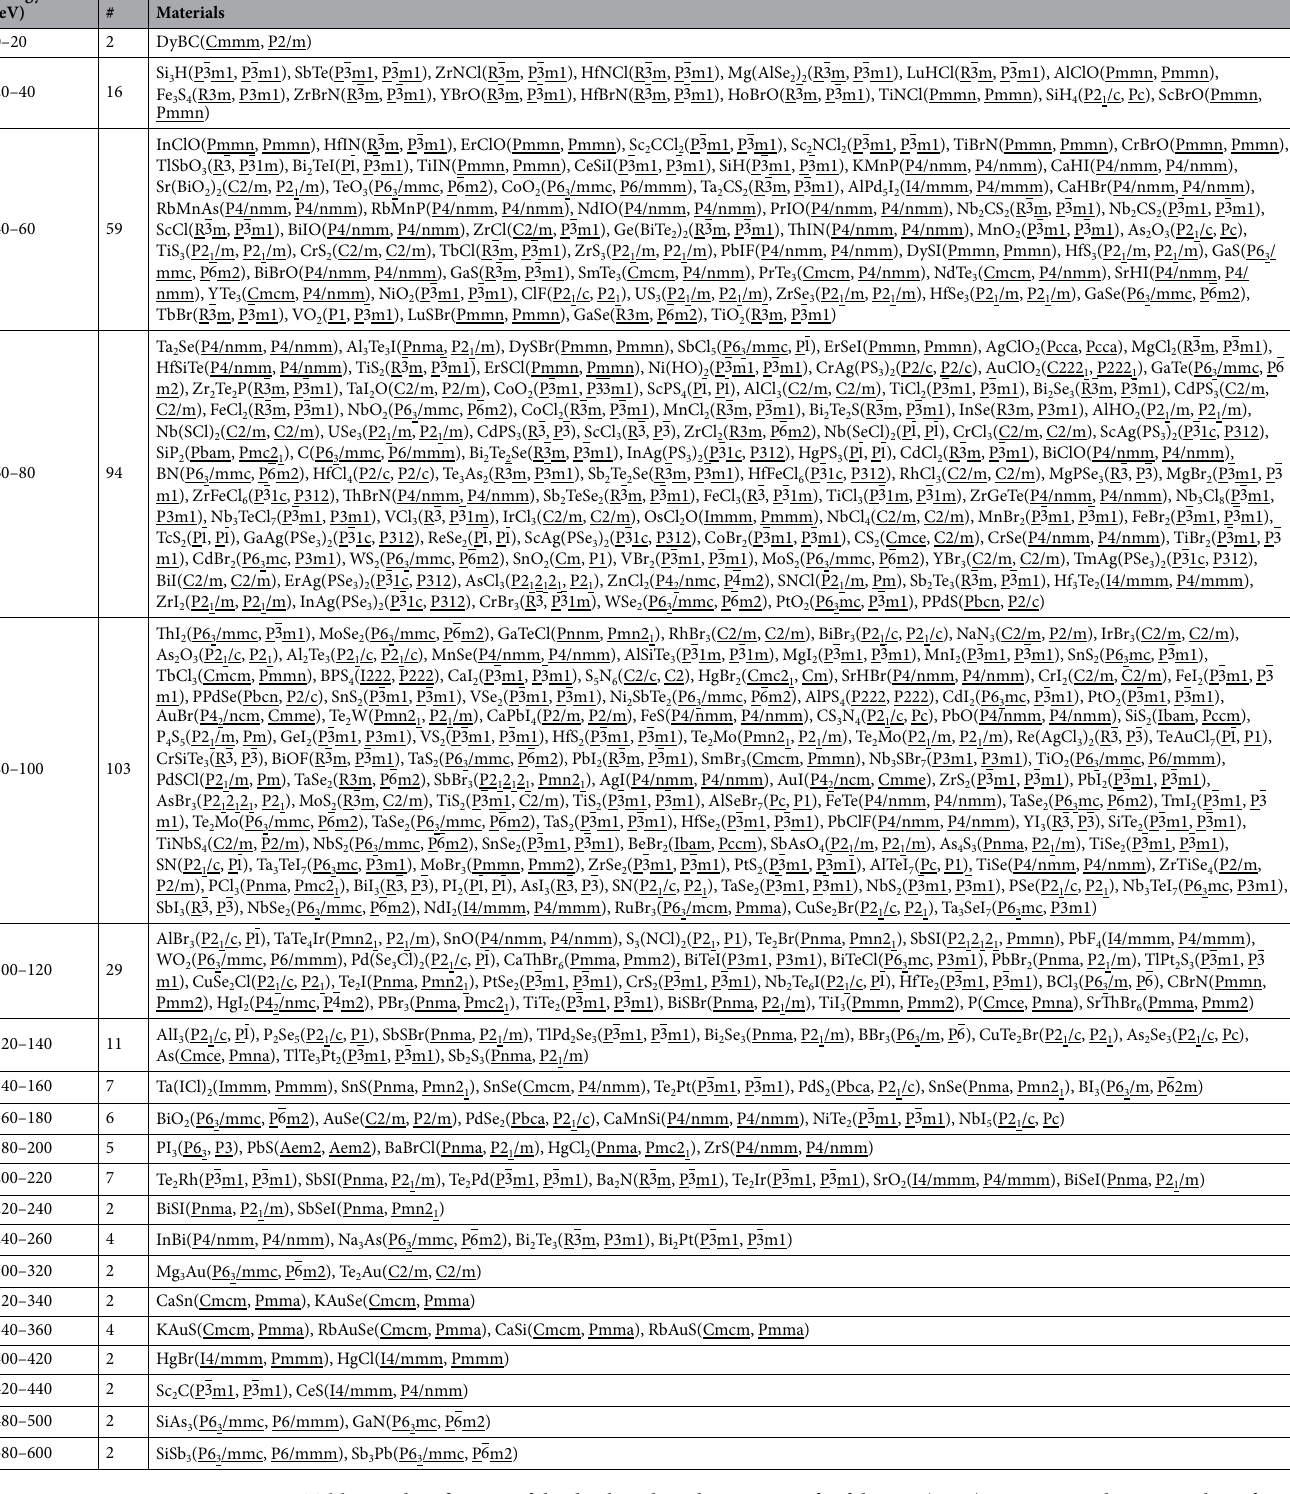
Table 1. Classification of the database based on energy of exfoliation (meV). Out 1356 only 430 number of materials have both bulk and single layer calculation completed and the rest of the calculations are underway. The table is updated online (website: www.ctcms.nist.gov/~knc6/JVASP.html) as further calculations get completed. Chemical compositions as well as their bulk and single layer space groups hyperlinked to our database are provided in